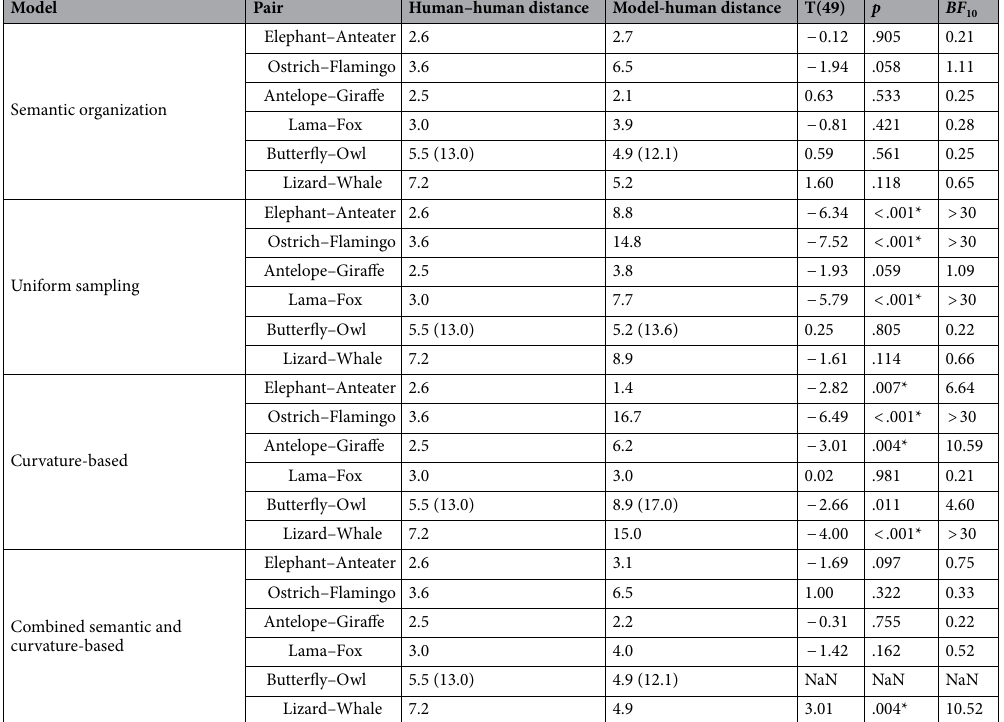
Table 1. Overview of modeling results and statistics for Experiment 1. Significant p values are marked with an asterisk (Bonferroni-corrected significance level p < .008). Note that the combined semantic and curvature- based model is tested against the semantic organization model rather than against human data (NaNs follow from exactly the same values for both